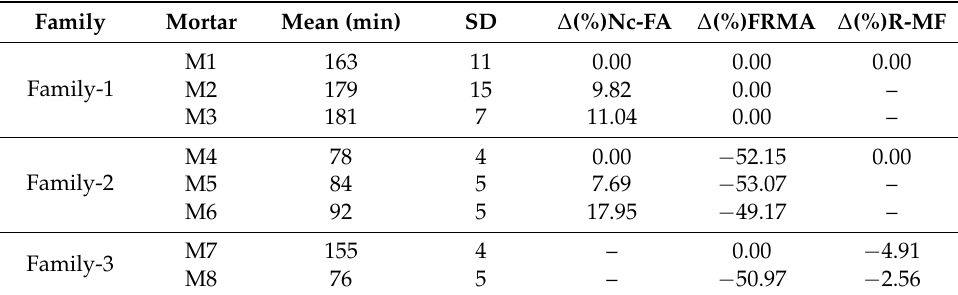
Table 8. Workability of fresh